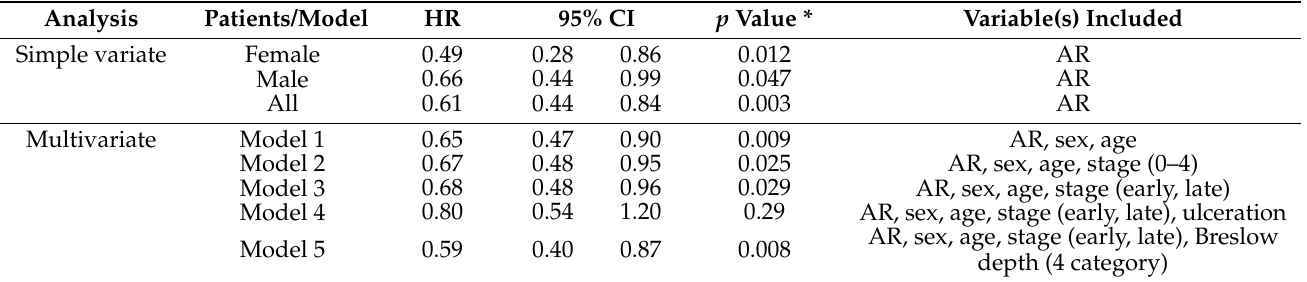
Table 3. AR is significantly associated with overall survival in melanoma patients.